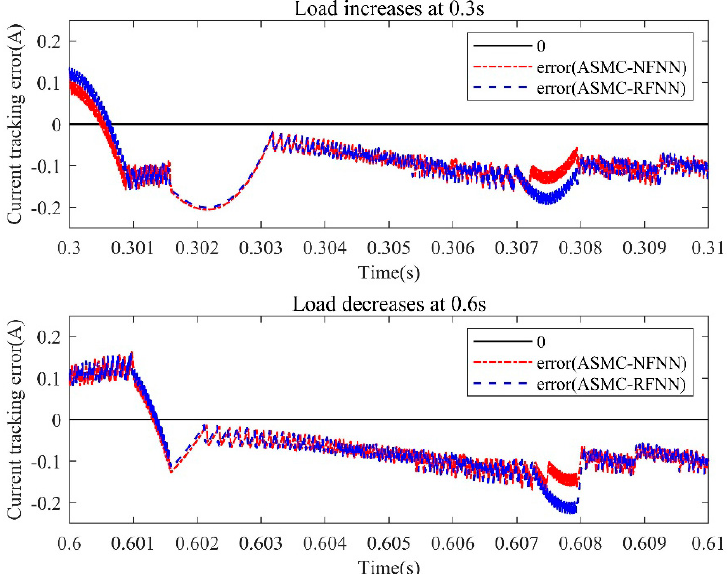
Figure 17. Enlarged curves of current tracking error (load increases at 0.3 s, load decreases at 0.6 s).